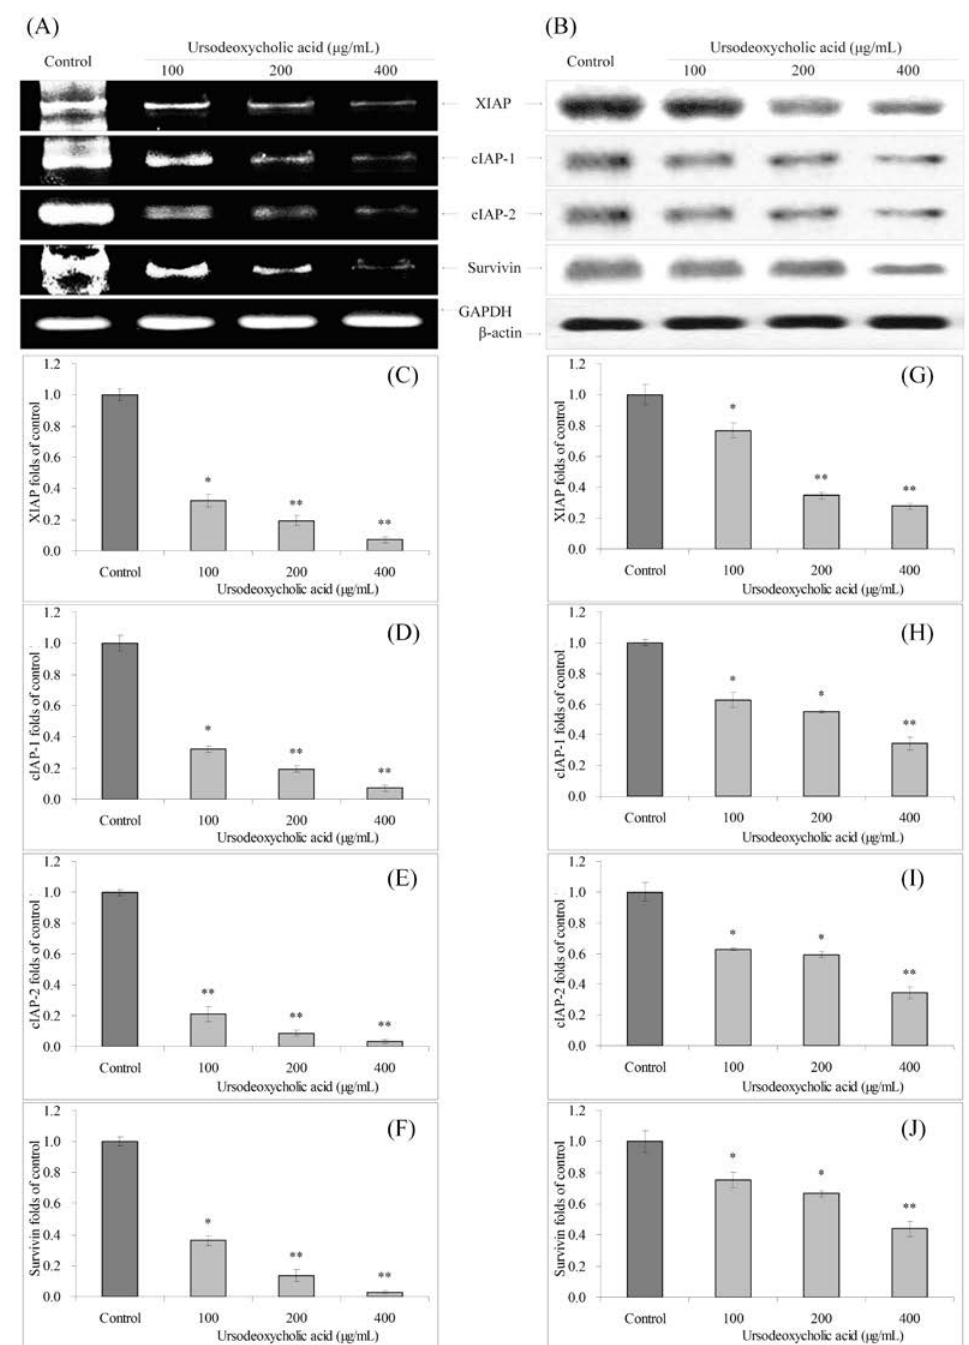
Figure 5. Effects of ursodeoxycholic acid (UDCA) on the mRNA ( A ) and protein ( B ) expression of XIAP, cIAP-1, cIAP-2 and survivin in human oral squamous carcinoma HSC-3 cells. Fold-ratio: gene expression/GAPDH (β-actin) × control numerical value (control fold ratio: 1); ( C ), XIAP mRNA expression folds of control; ( D ), cIAP-1 mRNA expression folds of control; ( E ), cIAP-2 mRNA expression folds of control; ( F ), survivin mRNA expression folds of control; ( G ), XIAP protein expression folds of control; ( H ), cIAP-1 protein expression folds of control; ( I ), cIAP-2 protein expression folds of control; and ( J ), survivin protein expression folds of control. * Mean values are significantly different from control ( p < 0.05) and ** mean values are significantly different from control ( p <